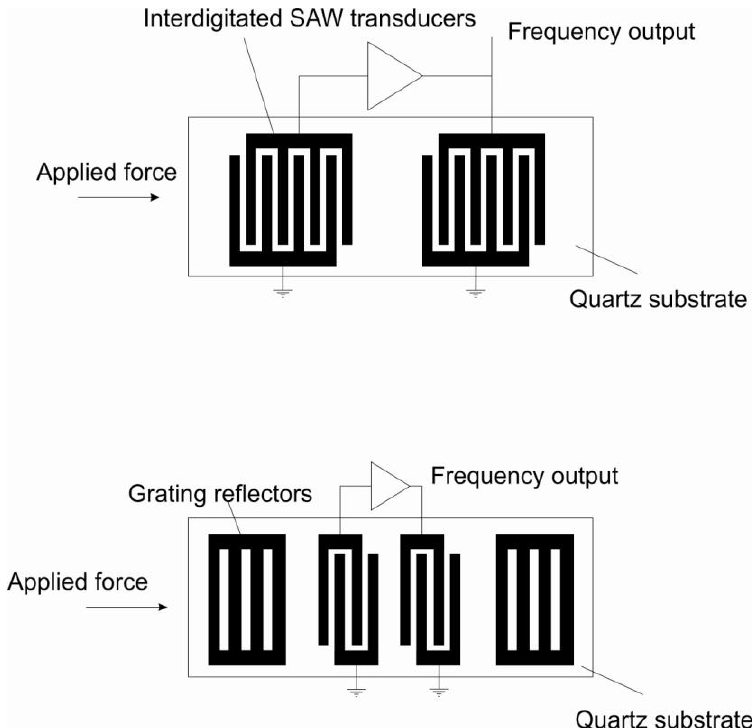
Figure 5. Frequency analog device, analogous modes of operation